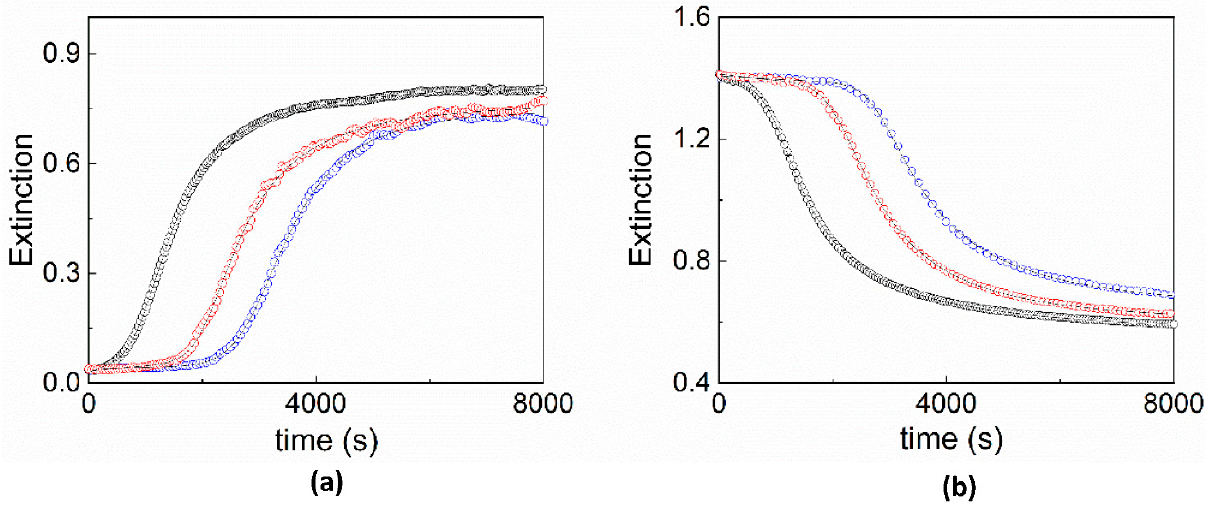
Figure 1. Extinction kinetic profiles recorded at 492 nm ( a ) and 434 nm ( b ) for the aggregation of H 2 TPPS 44 − induced by adopting three different reagent mixing order protocols (black traces—mix 1; red traces—mix 2; blue traces—mix 3). Experimental conditions: [H 2 TPPS 44 − ] = 3 µ M; [HCl] = 0.3 M; [NaCl] = 0.2 M, T = 298 K. The solid lines show the best fit of the experimental data to Equation (1).